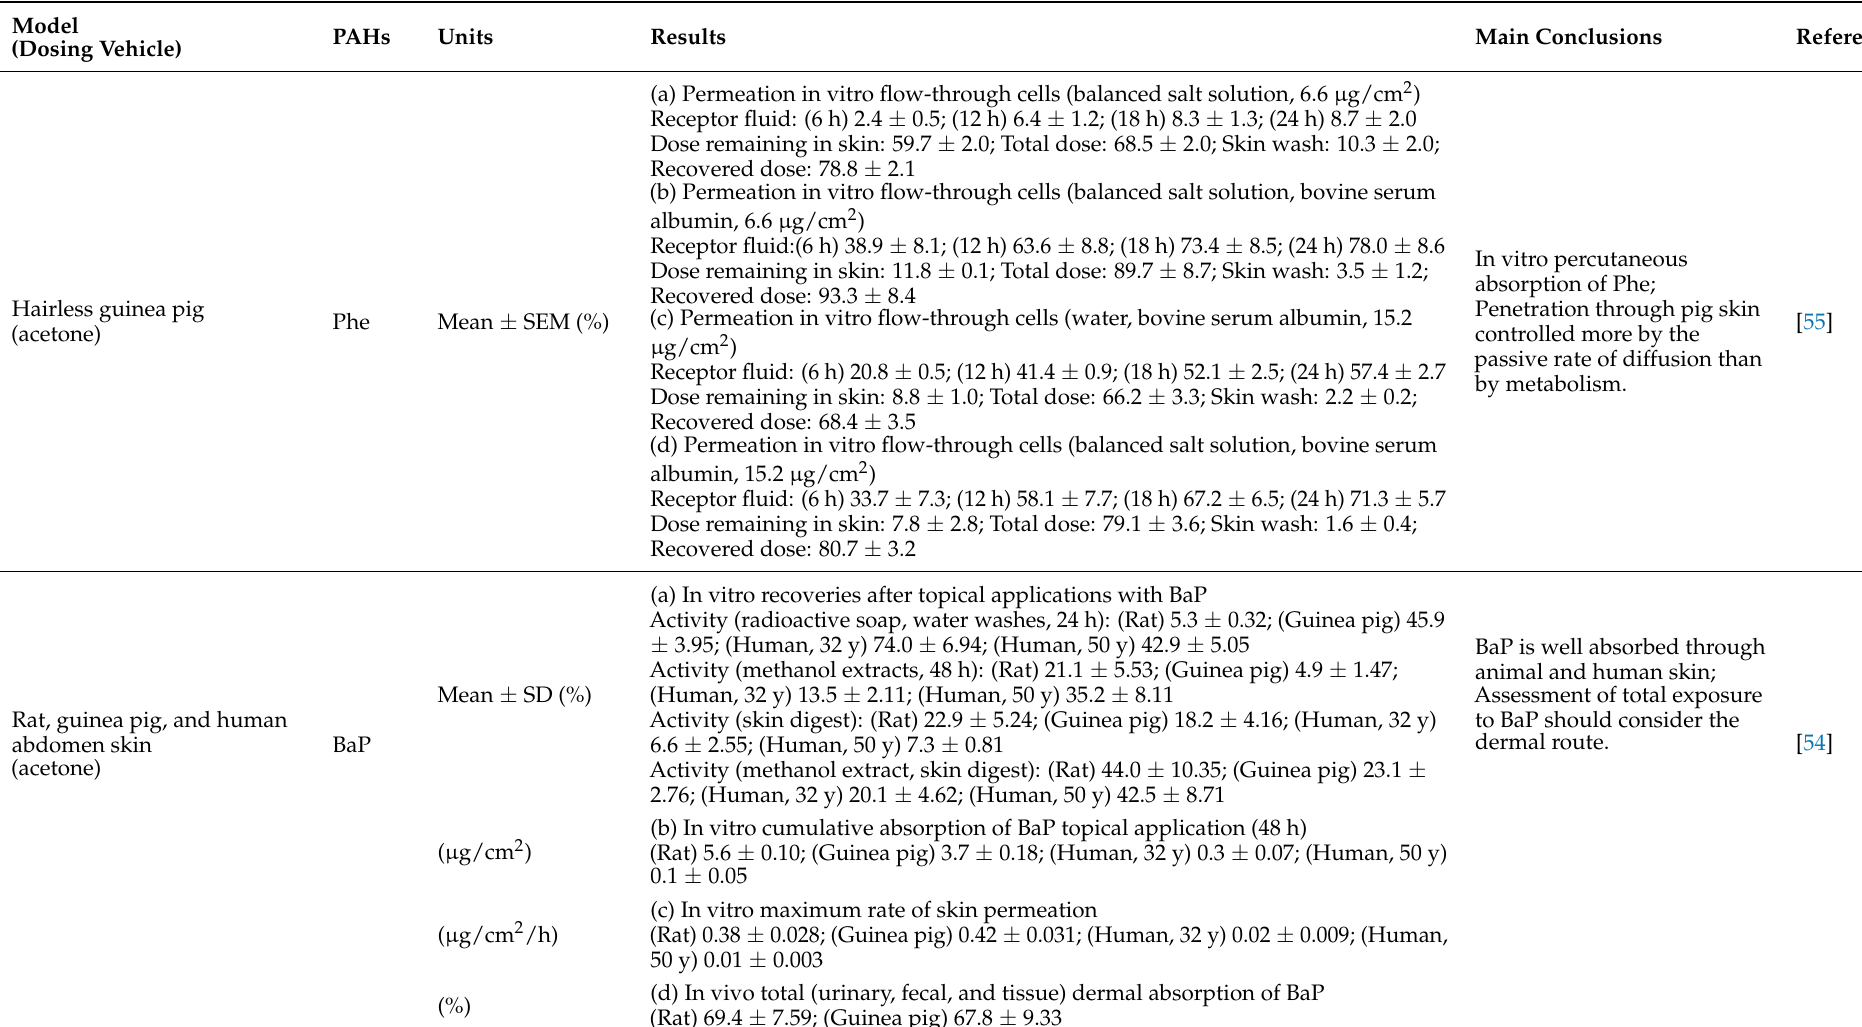
Table 1. Data collected from in vitro/in vivo studies assessing dermal absorption of